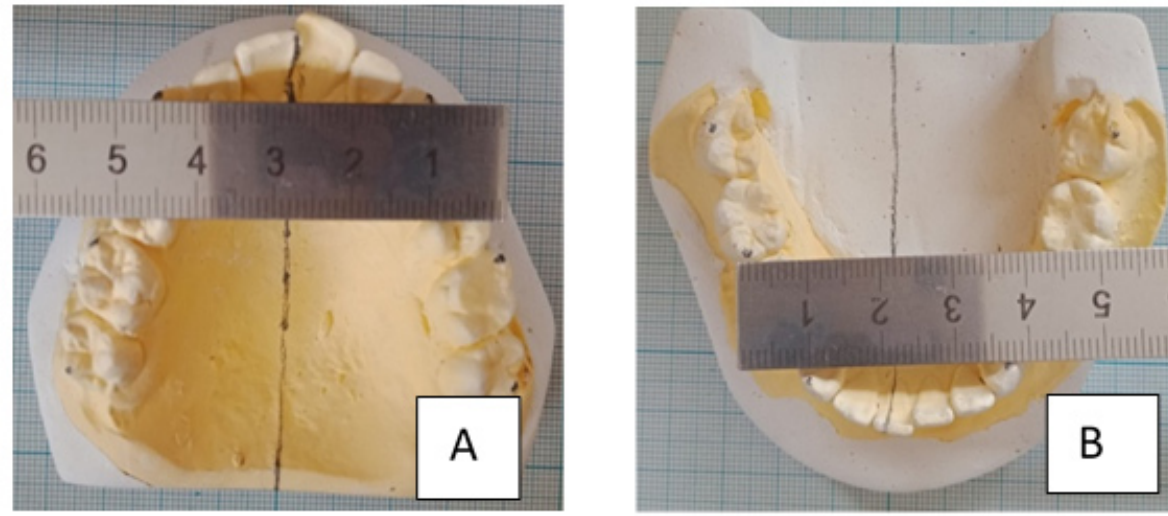
Figure 3. Measuring distance of the canines in upper and lower arch